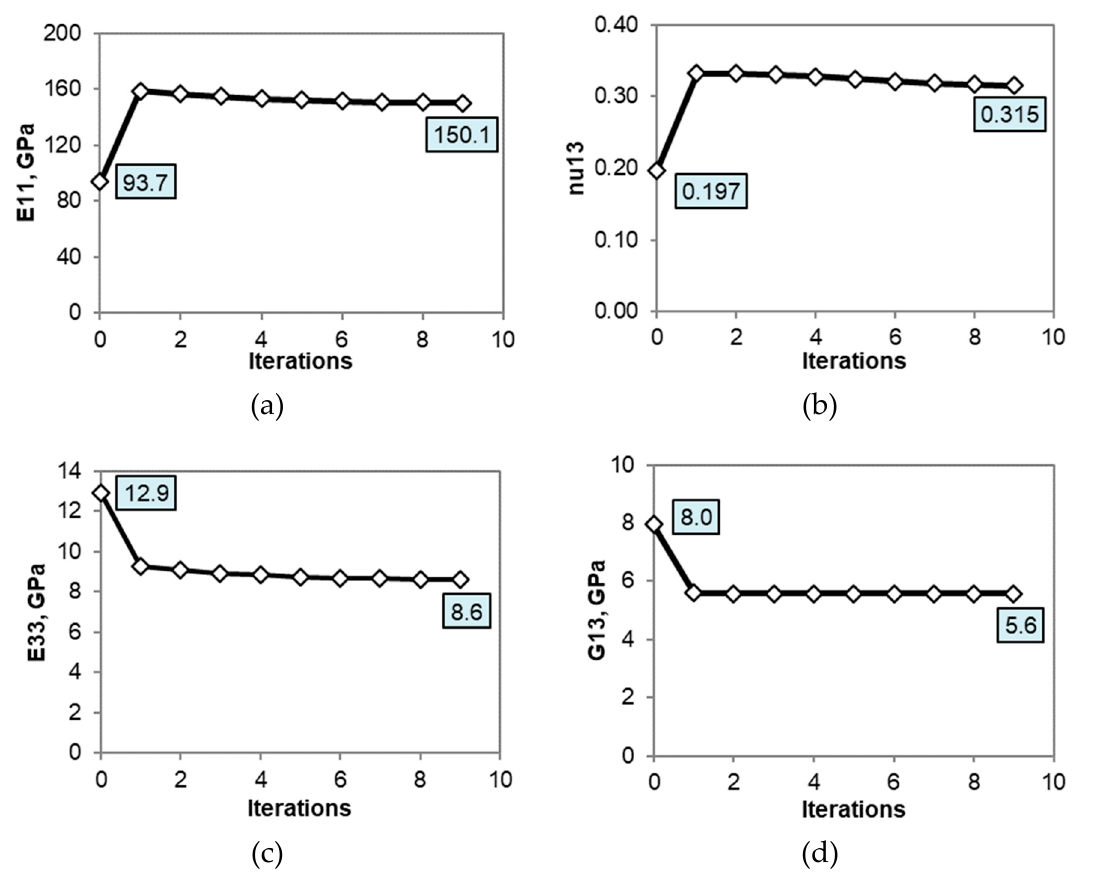
Figure 11. Convergence of the four material parameters ( a ) E 11 , ( b ) ν 13 , ( c ) E 33 and ( d ) G 13 extracted with the OHC-ILT FEMU methodology using DIC-measured strain data from a generic unidirectional carbon/epoxy OHC test specimen.